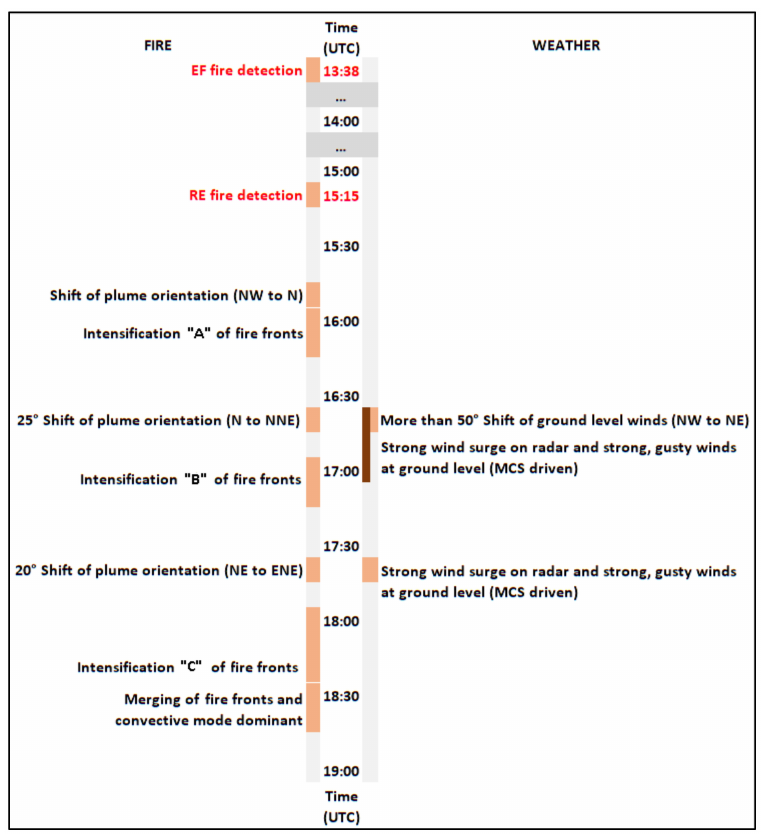
Figure 2. Timeline of the convectively induced flows and their influences on the evolution of the Pedr ó g ã o Grande fires on 17 June 2017. Plume orientation is expressed as the direction from which the plume is being driven by the wind. Wind orientation is expressed as the direction from which the wind is blowing. “A”, “B” and “C” refer to events of fire intensification (Section 5).